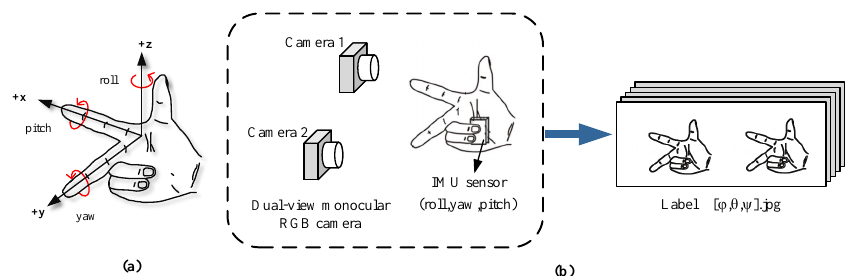
Figure 2. ( a ) Cartesian coordinate hand posture. ( b ) Diagram of dual-view data